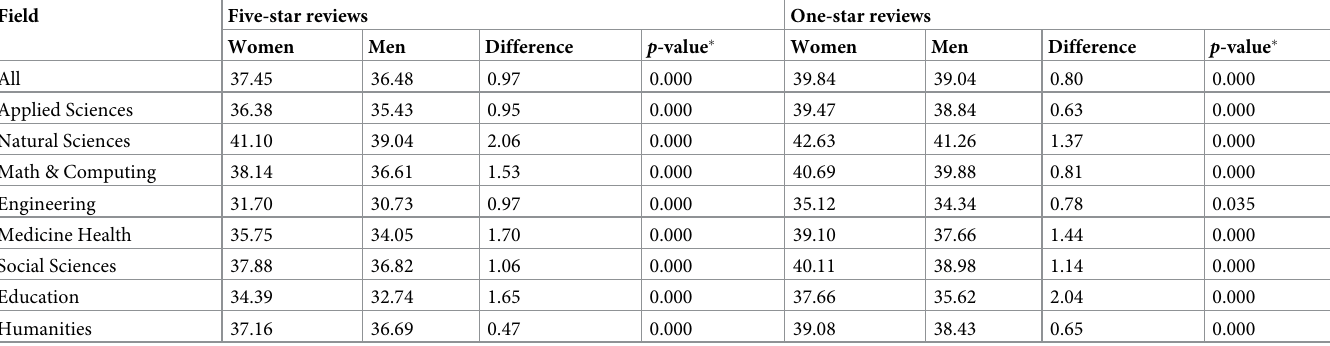
Table 3. Average word counts of comments per review by field and gender.